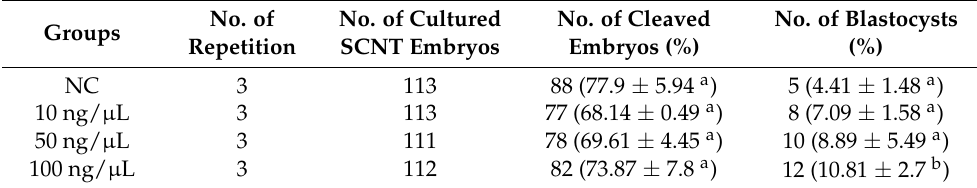
Figure 5. Overexpression of GADD45B in cloned pig embryos. ( A ) Map of the porcine GADD45B expression plasmid. ( B ) Expression of EGFP marker gene at 2-cell stage of injected cloned pig embryos. Bar = 100 µm. ( C ) Total cell number at blastocyst stage of SCNT embryos injected with GADD45B expression plasmid. Table 6. Developmental efficiency of SCNT embryos injected with GADD45B expression plasmid.